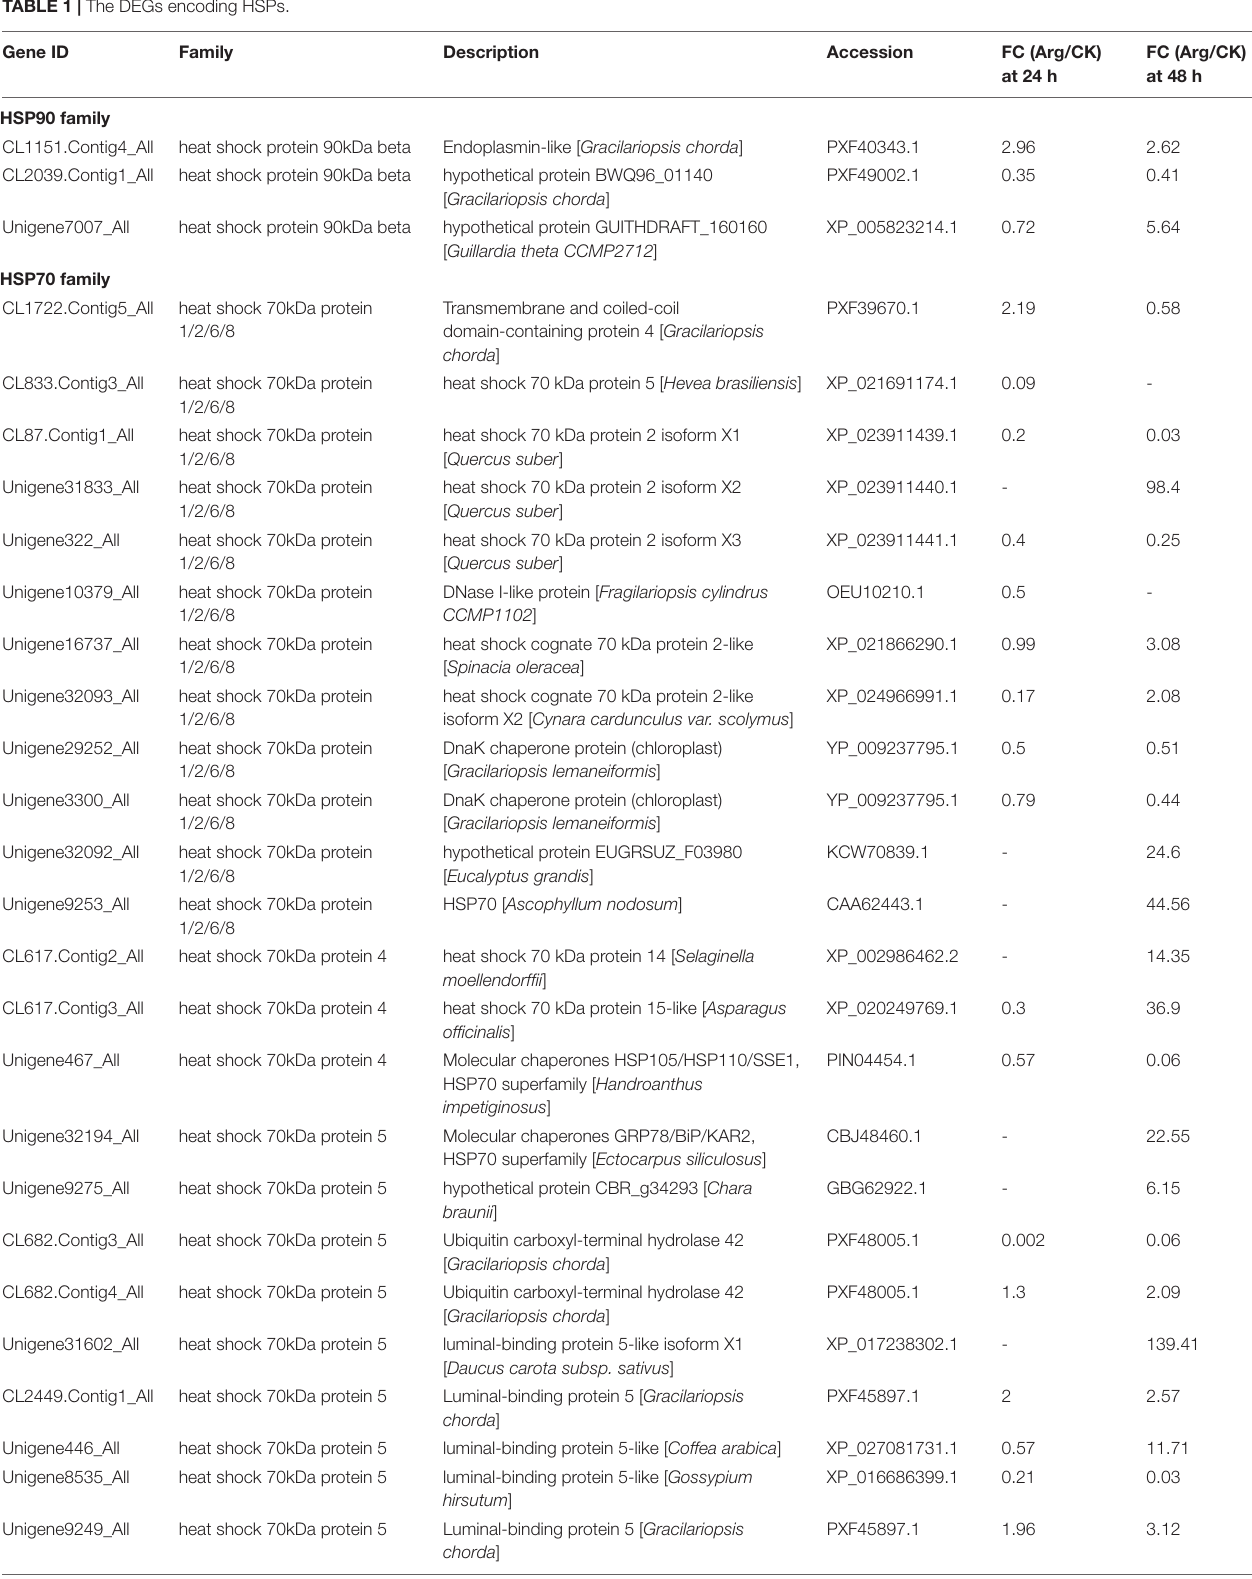
TABLE 1 | The DEGs encoding